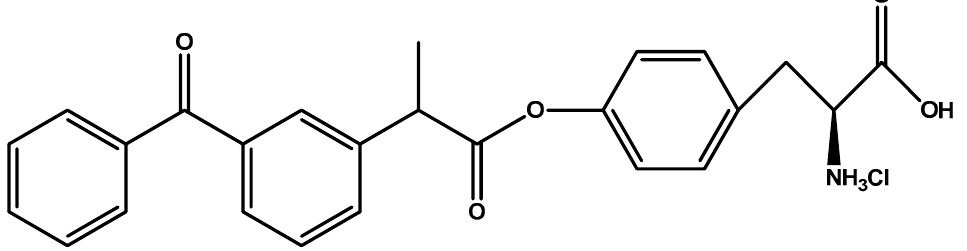
Figure 8. Chemical structure of ketoprofen prodrug targeted at LAT1 for CNS penetration.